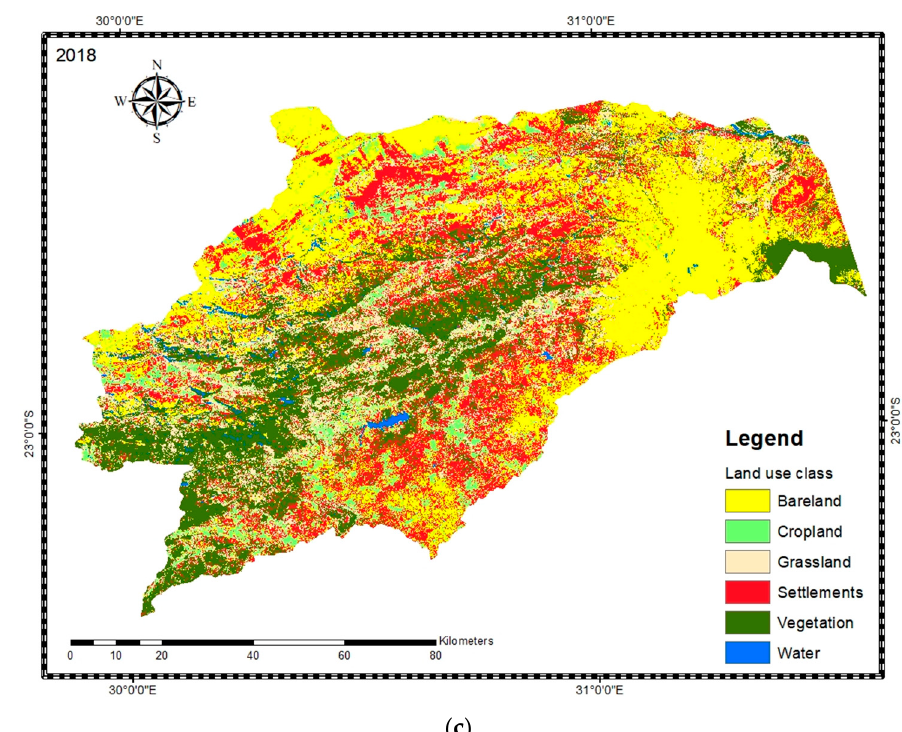
Figure 13. Land-cover maps for the Nzhelele and Levuvhu river catchments for ( a )1999, ( b ) 2008 and ( c ) 2018.